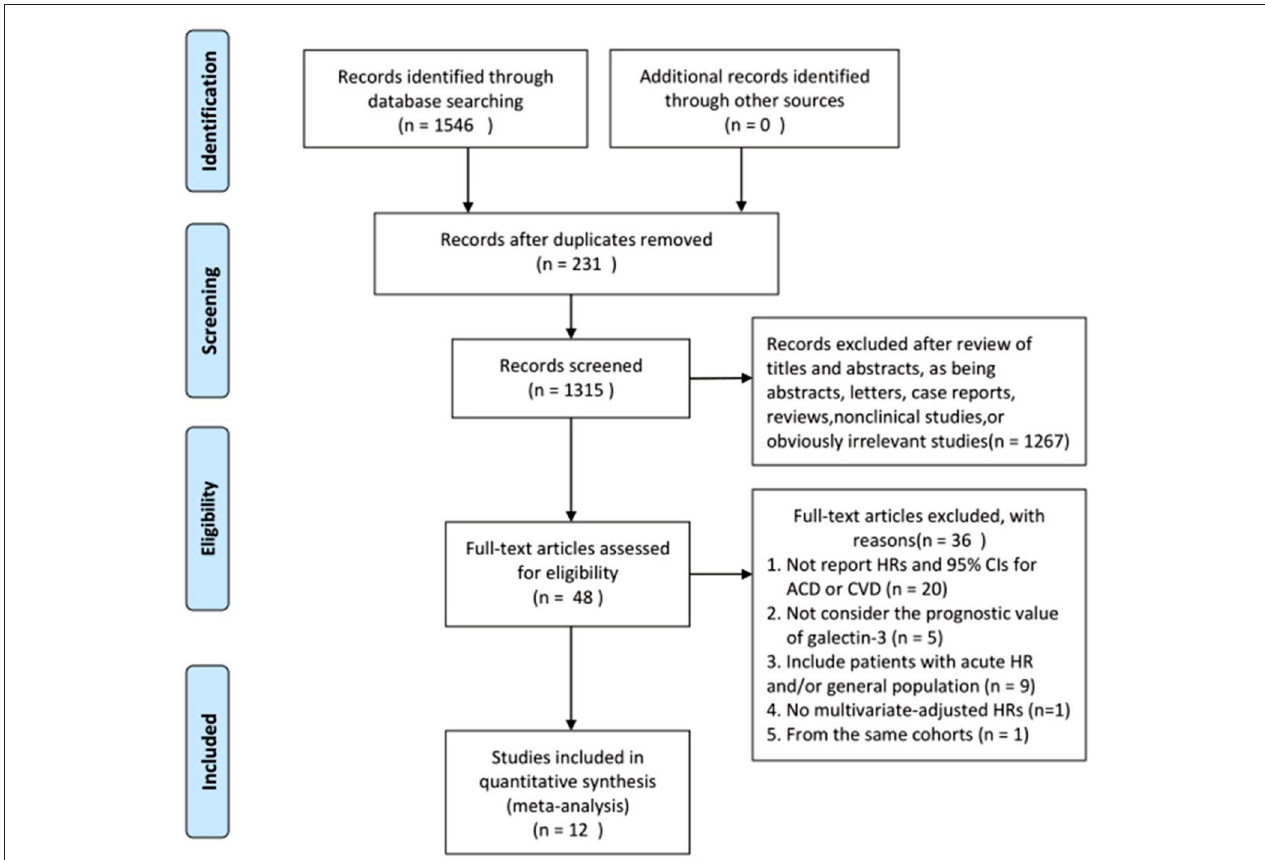
FIGURE 1 | Flowchart of study selection. HRs, hazard ratios; CIs, confidence intervals; ACD, all cause death; CVD, cardiovascular death.